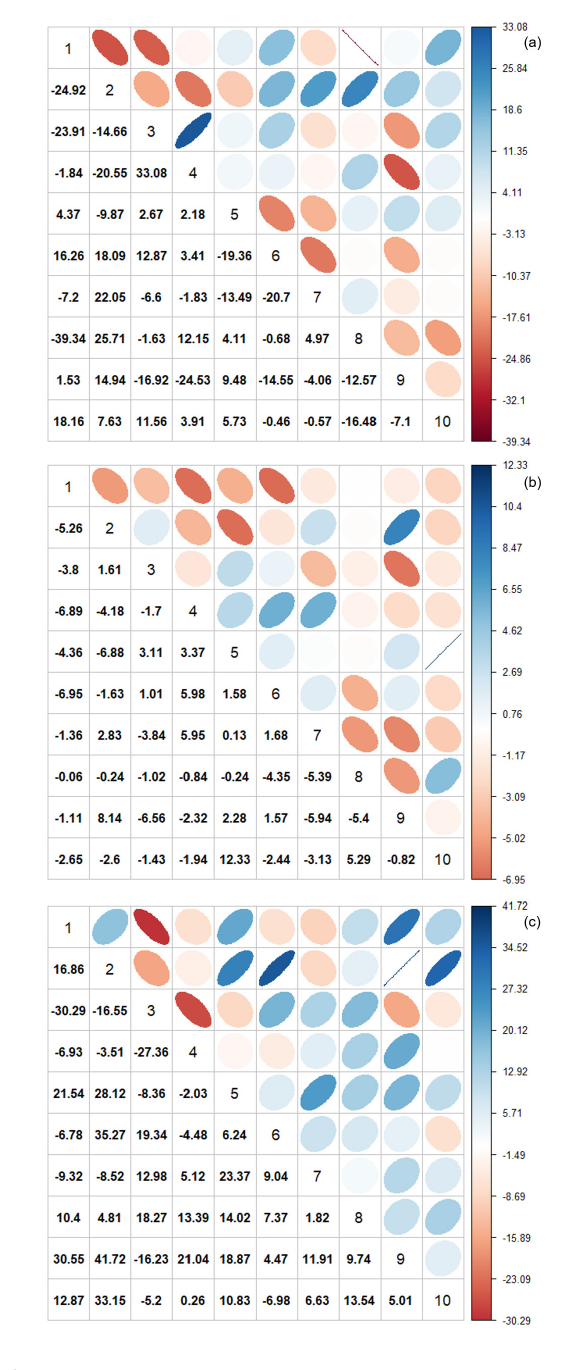
Figure 5. Reciprocal specific combining ability for mega-trait 1 (plant stature) of 90 crosses conducted in Frederico Westphalen (a), Pato Branco (b) and Campos Novos